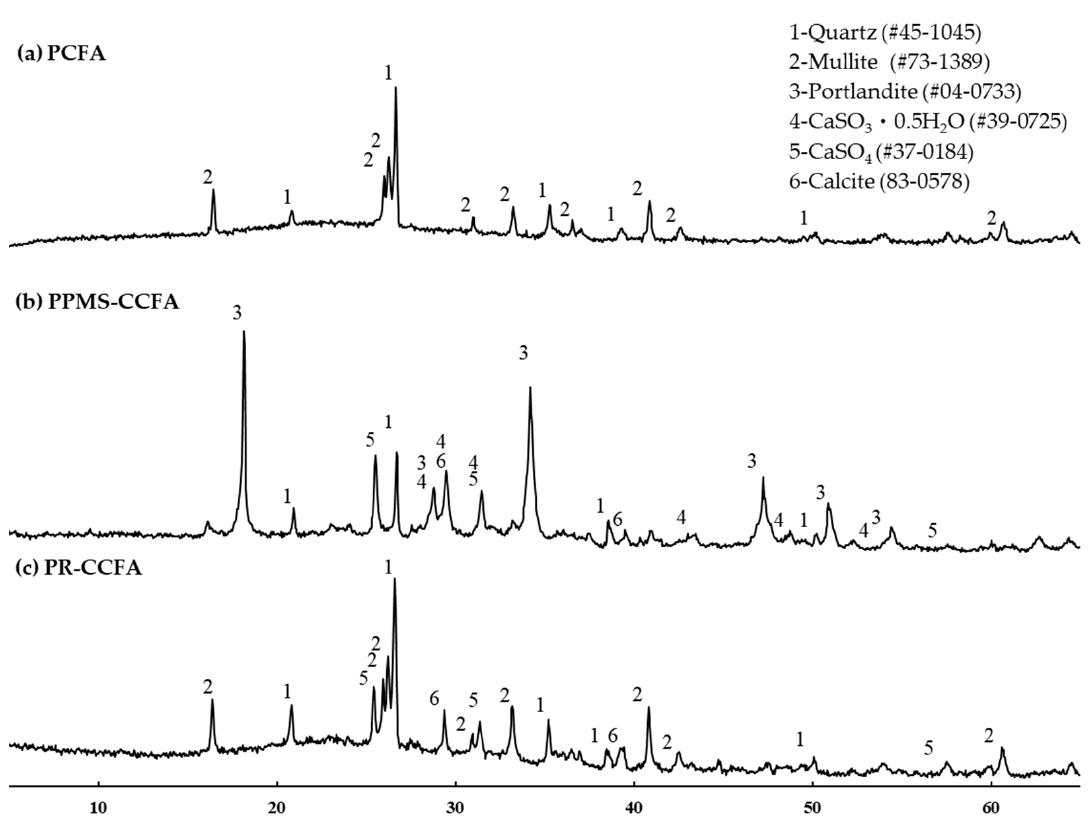
Figure 2. Fly ash X-Ray diffraction patterns.